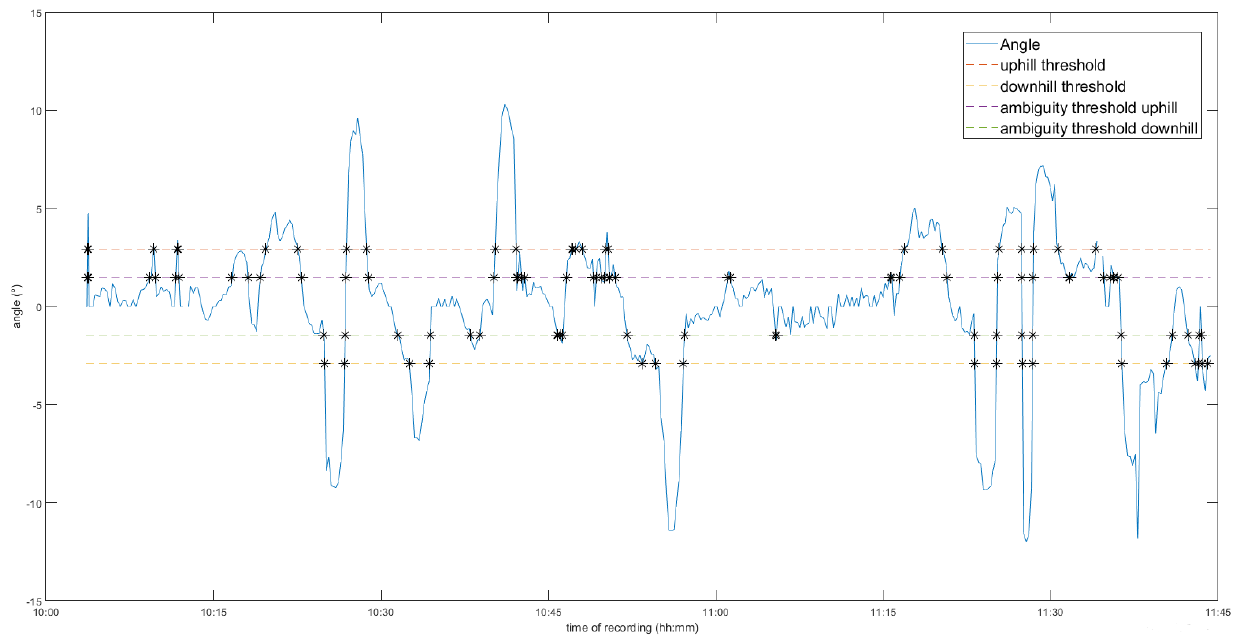
Figure 3. Example of a slope angle plot for one participant’s